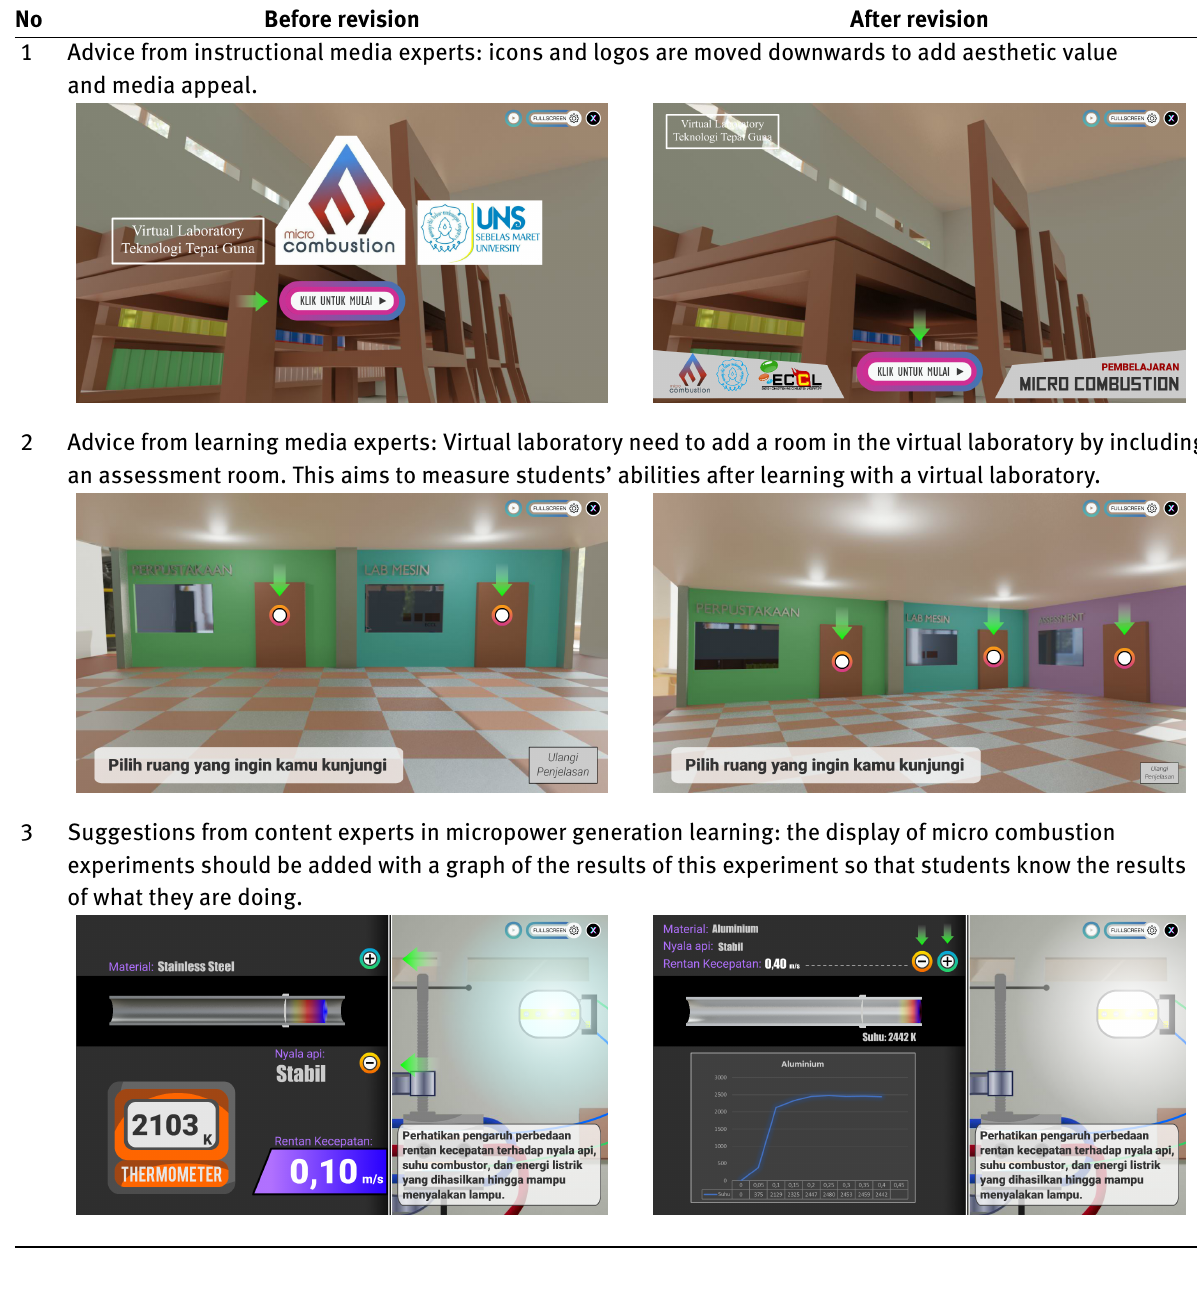
Table 4: The results of validation by learning media and micropower generation experts